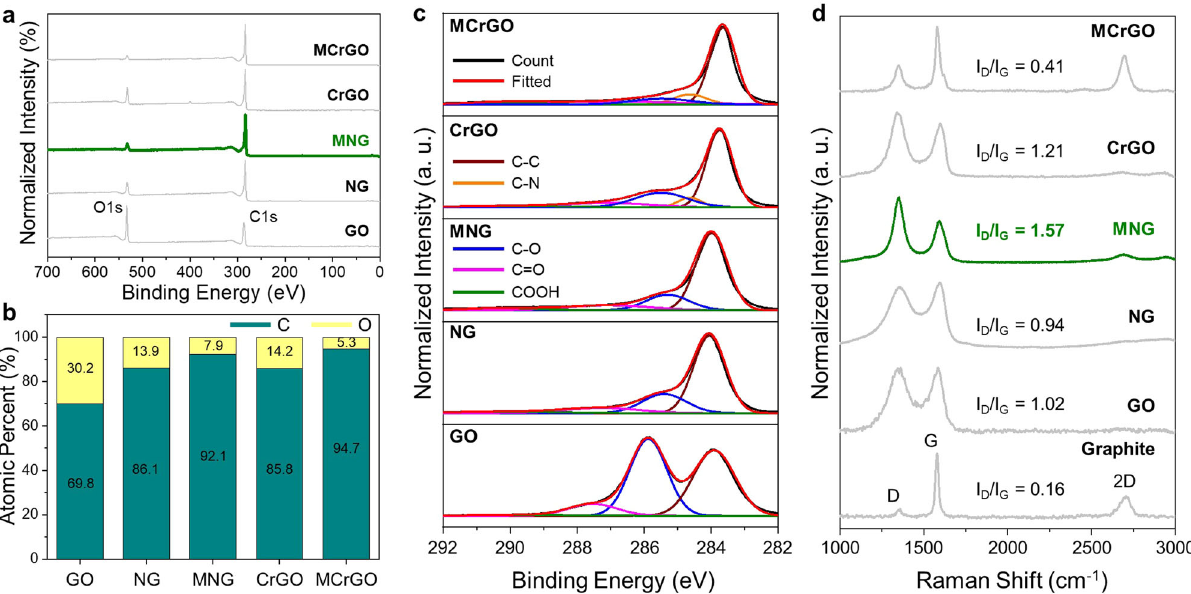
Fig.3|Chemicalstructureofgraphenematerials.a XPSsurveyscan,and b correspondingatomicpercentageofGO,NG,MNG,CrGO,andMCrGO. c XPSC1sspectraand d Raman spectra of GO, NG, MNG, CrGO, and MCrGO. Raman spectra were measured using an excitation wavelength of